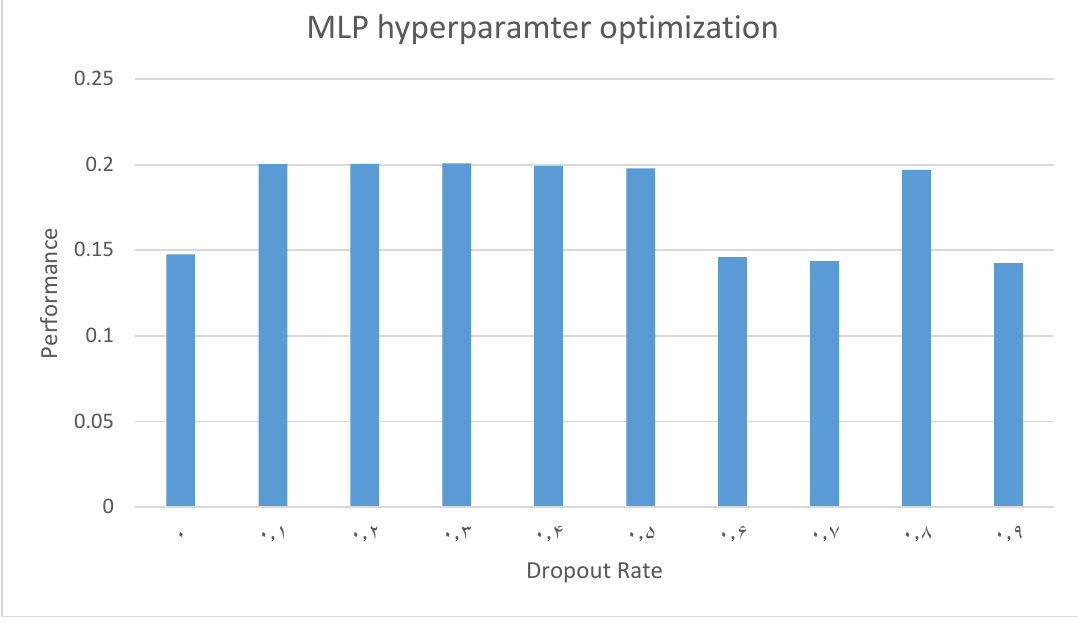
Figure A-3 Optimized Dropout Rate of MLP models